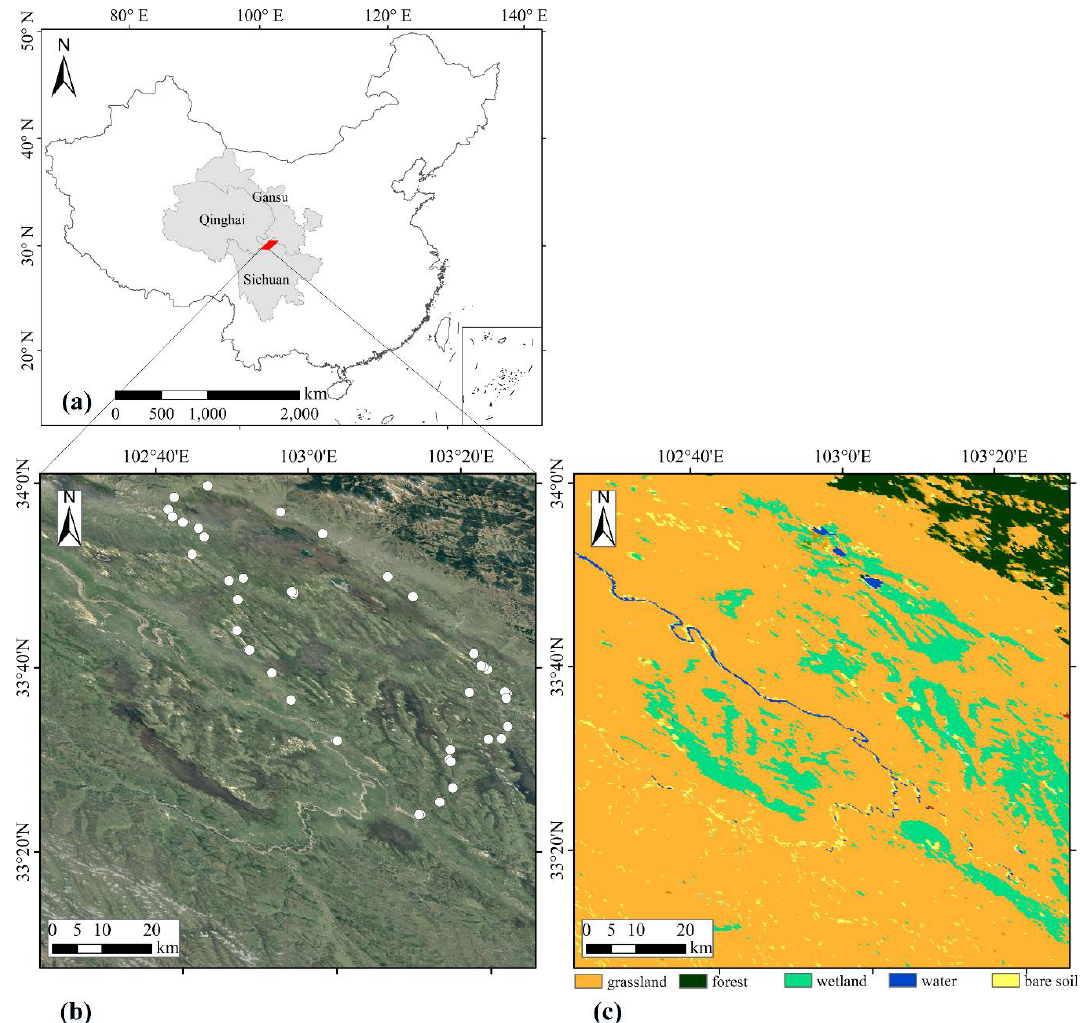
Figure 1. ( a ) Location of the study area; ( b , c ) a Google Earth image and the land cover of the study area, respectively. Sampling plots for the field aboveground biomass measurements are displayed as white dots in ( b ).